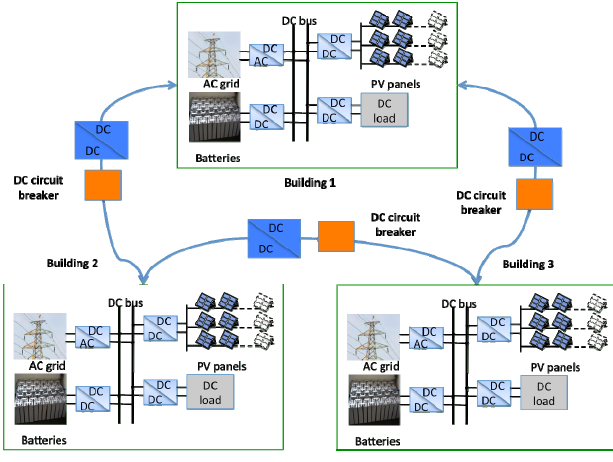
Figure 1. The layout of a mesh DC microgrid in a neighborhood.